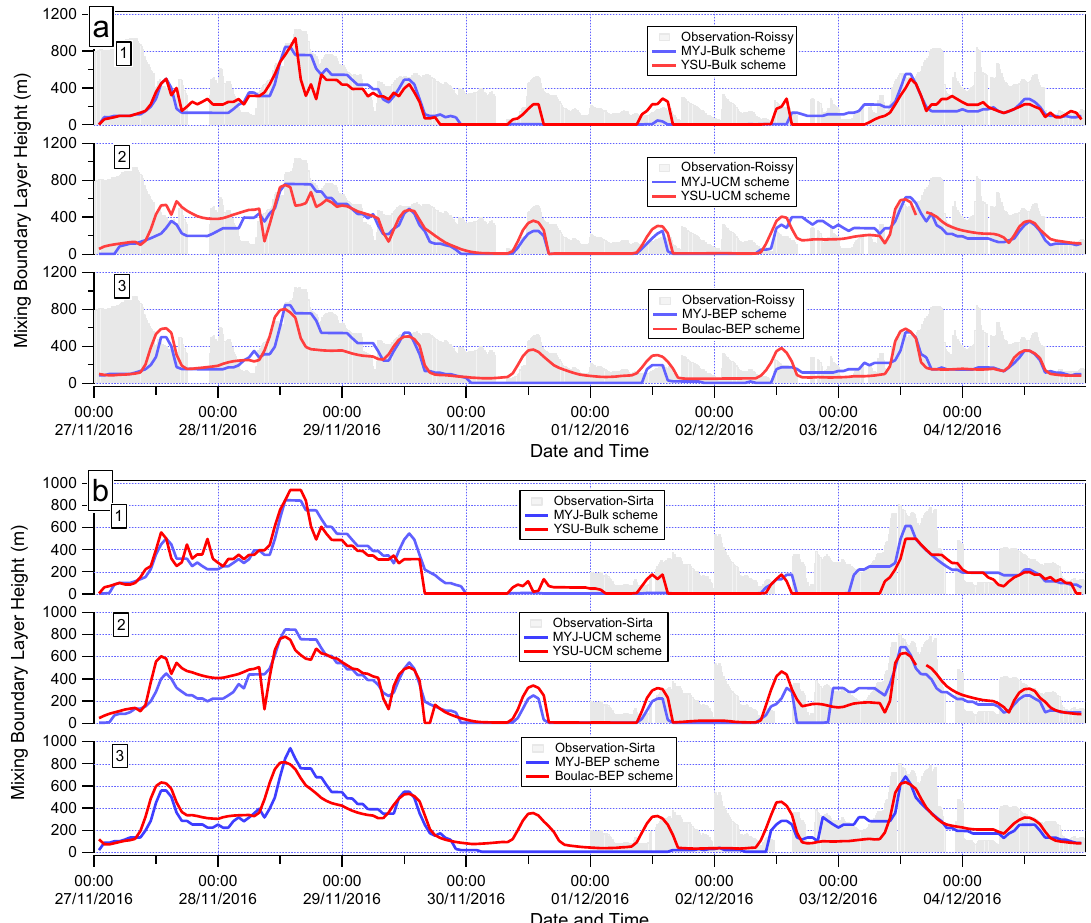
Figure 14. Time series of the observed and modelled mixing boundary layer height: ( a ) and ( b ) represent Roissy and Sirta station, respectively; 1, 2, and 3 represent each PBL scheme coupled with each urban canopy scheme.